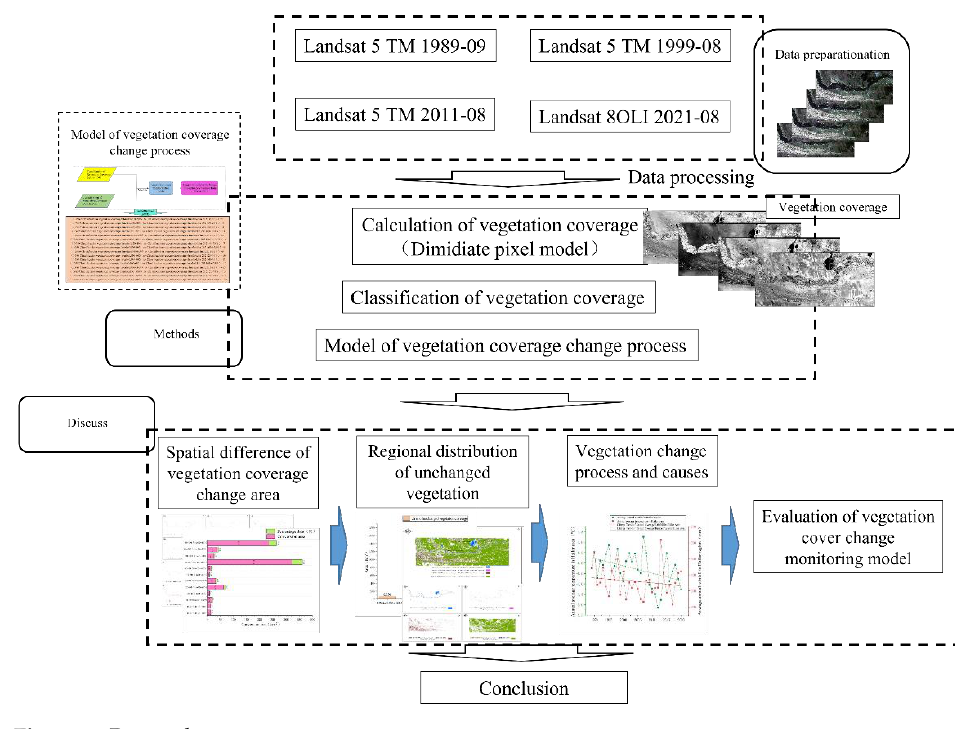
Figure 2. Research